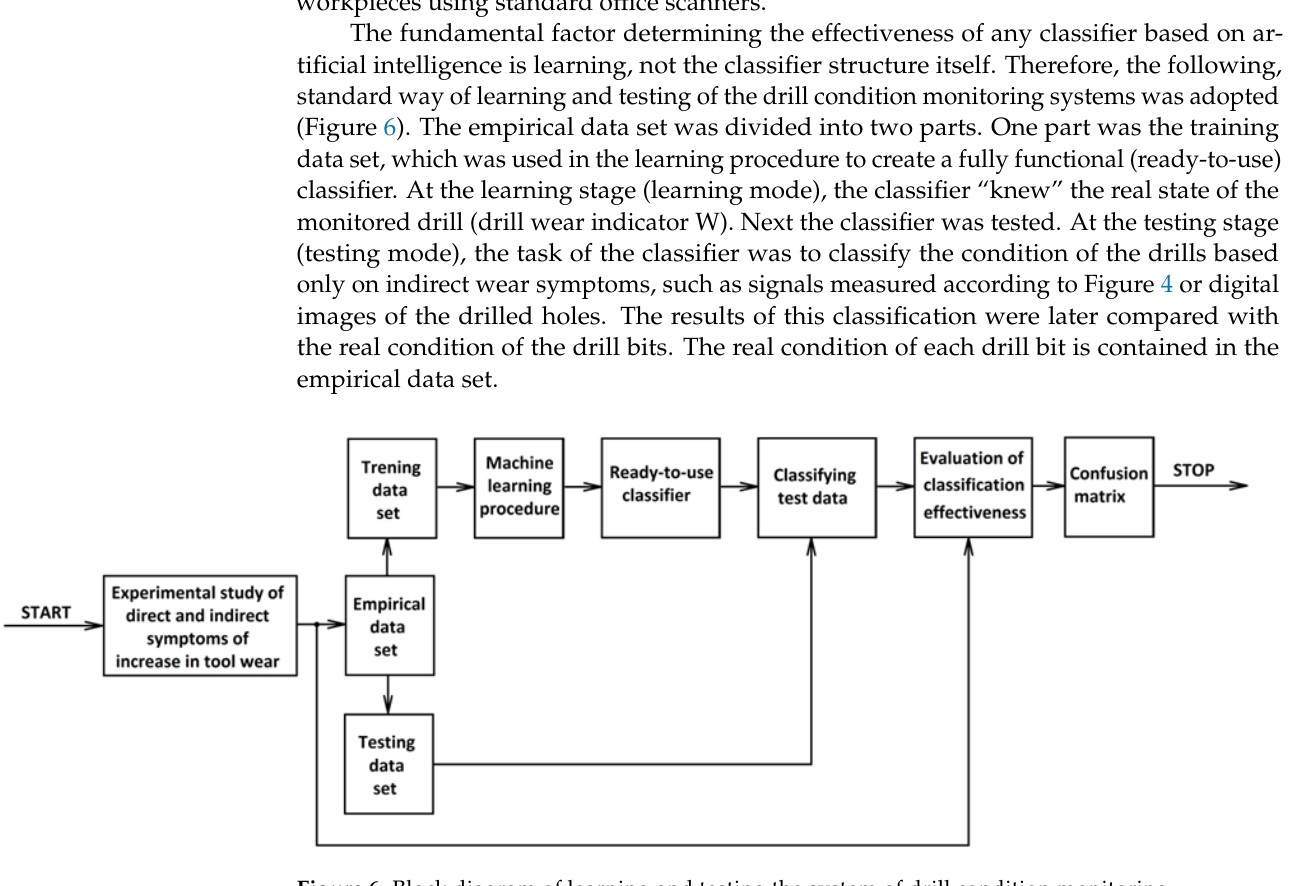
Figure 6. Block diagram of learning and testing the system of drill condition monitoring.